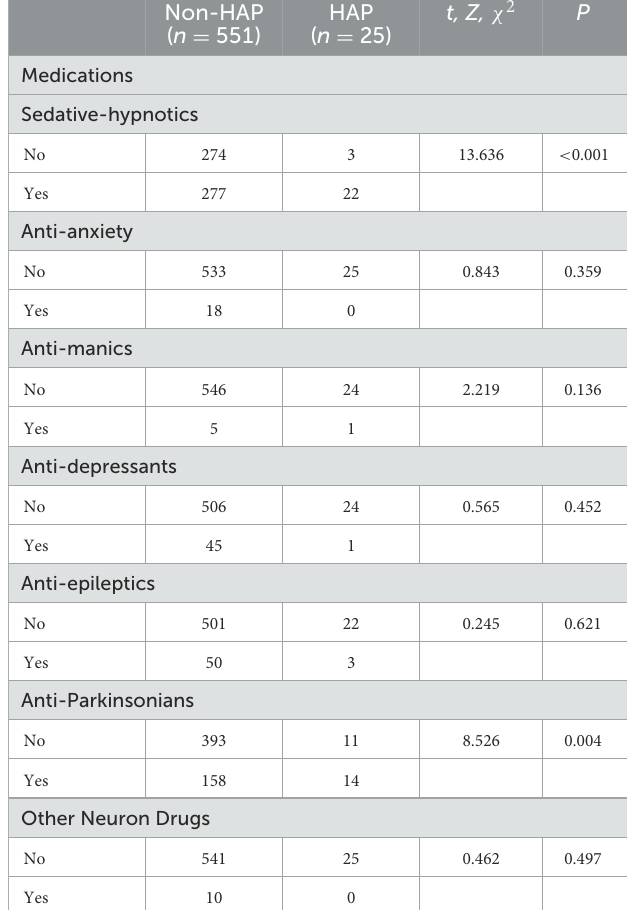
TABLE 4 Differences between HAP and non-HAP groups in female SCZ patients with